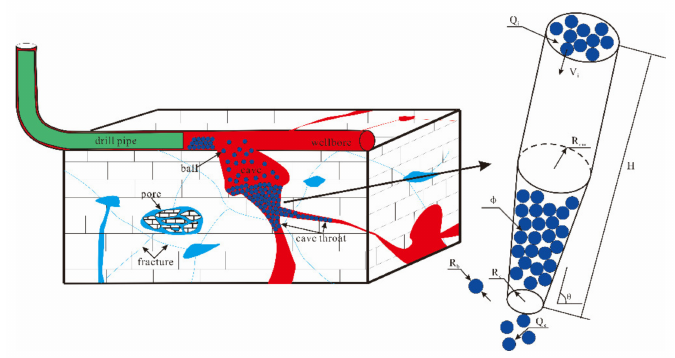
Figure 4. Some concepts to describe the geometric parameters of the model and the MBP process. (1) Cave neck radius R c : the radius of the cave neck, in mm. (2) Bridging ball radius r b : the size of the bridging ball used for MBP, in mm. (3) Cave dip angle θ : the angle between the horizontal axis and central axis of an ideal cave, in rad. (4) Bridging ball flow rate Q e at cave neck: the flow rate of bridging ball that flow out from the cave neck, in pcs/s; (5) Initial flow rate Q i of bridging ball: the flow rate for the bridging ball entering from the cave inlet, in pcs/s. (6) Initial velocity of the bridging ball V i : the initial velocity for the bridging ball entering from the cave inlet, in m/s. (7) Number of critical bridging ball N c : the minimum consumption of bridging ball for successful first-stage bridging, in numbers. (8) Critical initial flow rate: the initial flow rate at which first-stage bridging probability of success is higher than 90% (simulated 50 times), in pcs/s. (9) Porosity of first-stage bridging layer ϕ : the ratio of the void space in the cave to the cave space, in